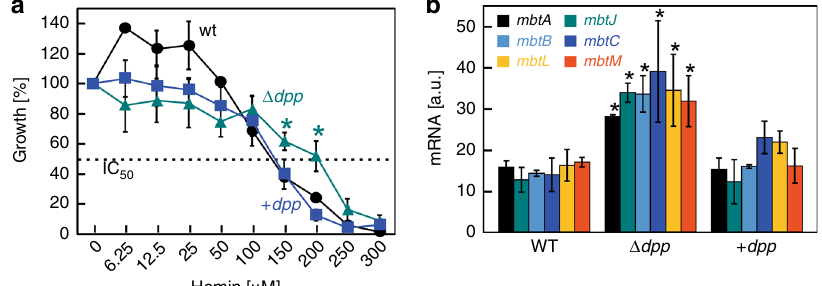
Fig. 3 The M. tuberculosis Δ dpp mutant is resistant to heme toxicity and experiences iron starvation. a Growth of wt Mtb (circles), the Δ dpp mutant (triangles), and the complemented Δ dpp mutant (squares) in HdB minimal medium with 1 µ M ammonium ferric citrate and increasing concentrations of hemin. Note that the scale of the y -axis is not linear. b The mRNA levels of mbt genes of wt Mtb, the Δ dpp mutant, and the complemented Δ dpp mutant in the presence of 10 µ M hemin were determined by quantitative real-time PCR. Error bars represent standard errors of mean values of biological triplicates. For all plots, asterisks denote signi fi cant differences for Δ dpp mutant compared to wt Mtb. Statistical signi fi cance was determined by Tukey ’ s HSD following an F -test ( p < 0.05). Source data are provided in the Source Data fi le